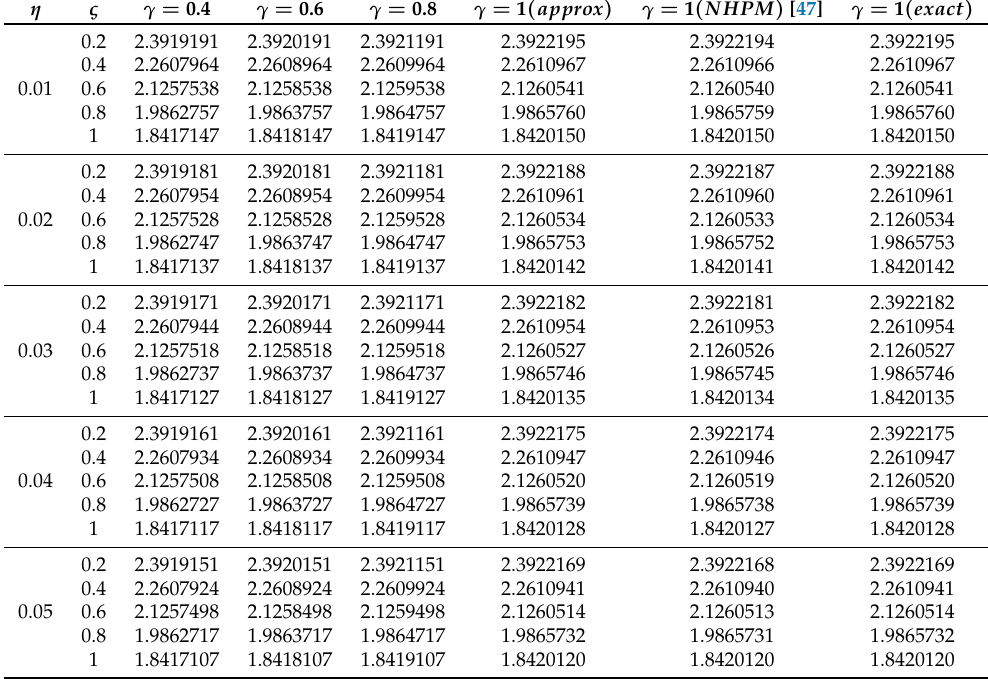
Table 3. Comparison of the accurate and suggested technique solution at different values of γ for problem